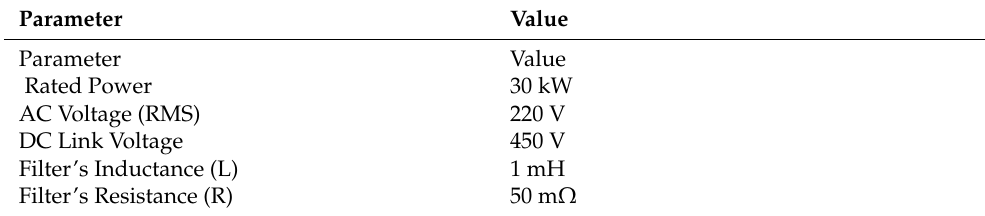
Table 1. Rated values and filter